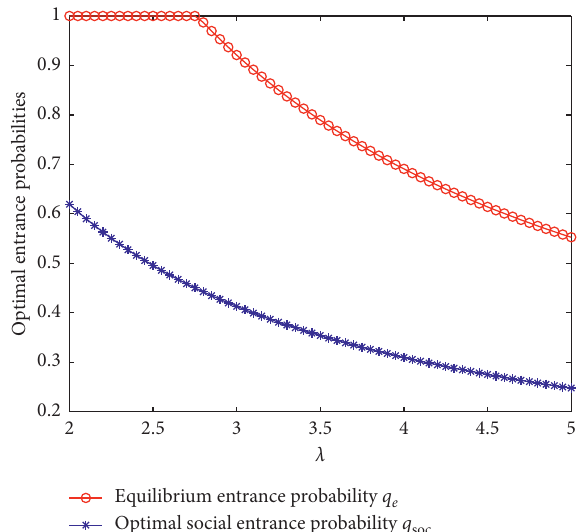
Figure 6: Equilibrium and social optimal joining probabilities versus λ ( C � 2 , R s � 4 , R f � 1 )